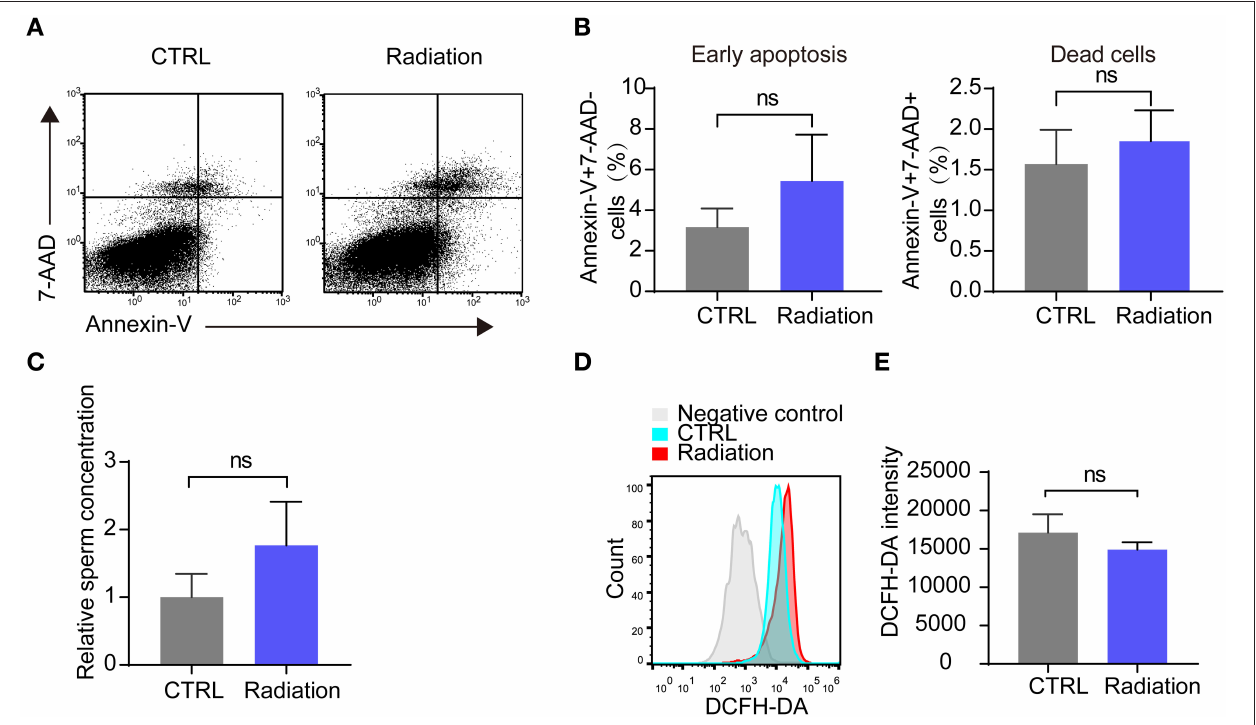
FIGURE 3 | Effects of RF-EMR on sperm quality. (A,B) The sperm apoptosis in the epididymis of Radiation and CTRL mice were detected by flow cytometry. (C) Epididymissperm numberof both groups determined by haemocytometer. (D,E) Mice sperm ROS (reactive oxygen species) were tested by DCFH-DA on a flow cytometry. (A–E) CTRL, mice in sham group; Radiation, mice in RF-EMR exposure group. ns, not significant . n = 6 for both groups. Student’s t